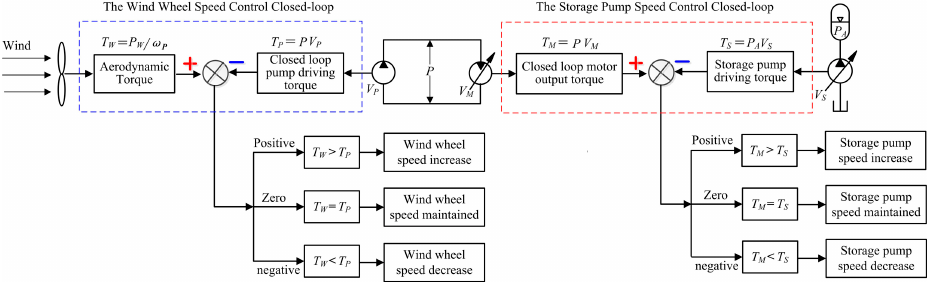
Figure 8. The torque relationship of the storage type wind turbine.